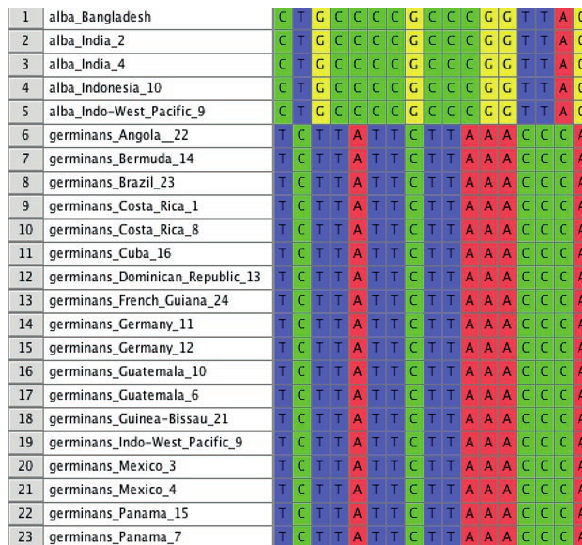
Figure 13. Barcode ITS sequences differentiating Avicennia alba and A. germinans .